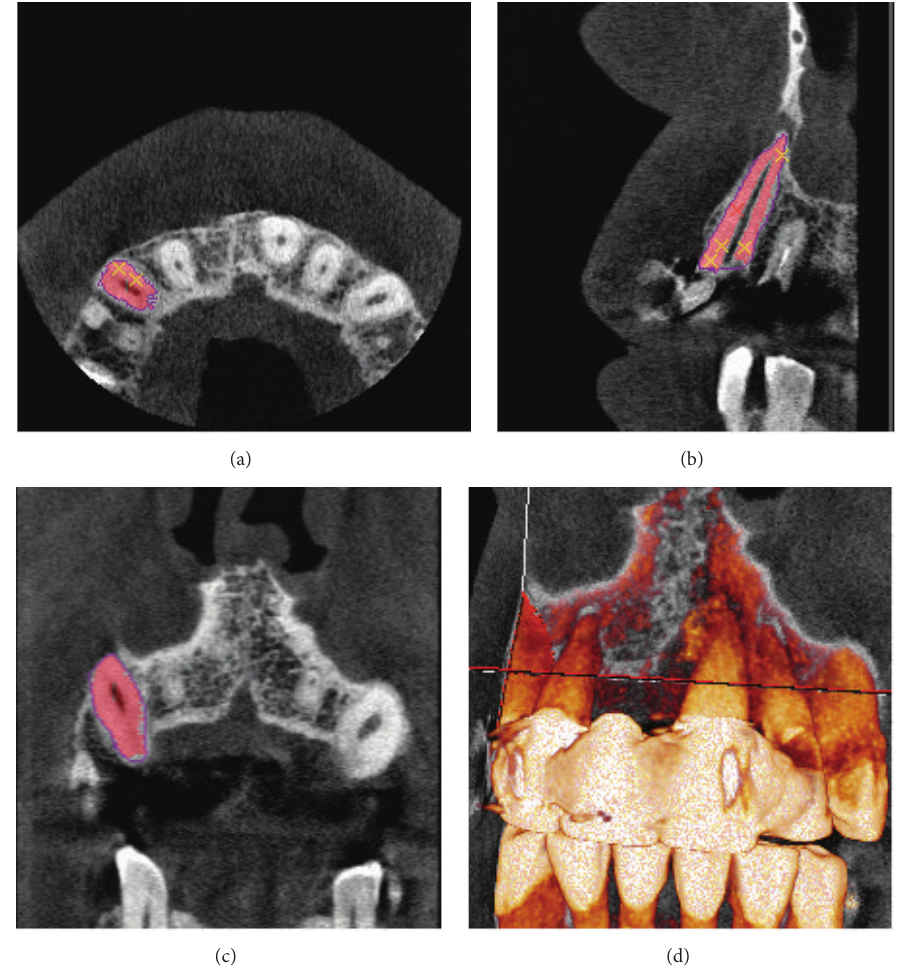
Figure 1: Segmentation and preparation of the RAI. Coronal (a), axial (b), sagittal (c), and 3D (d)